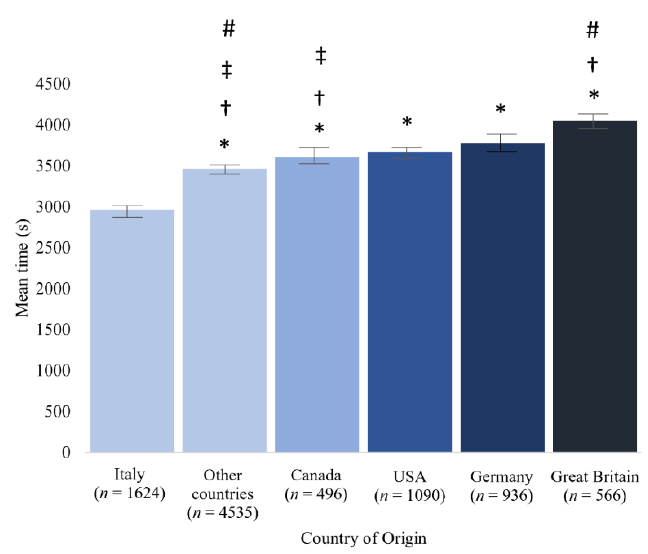
Figure 1. Mean times, confidence interval (95%) and difference between countries in 3000 m open- water swimming between 1992 and 2019. * different from Italy; † different from Germany; ‡ different from Great Britain; # different from USA. The number of participants from each country in each year varied between 1 and 1023. The three countries that most participated in 3000 m open-water swimming WC over the years where Italy had 1646 participations, the USA had 1128 participations and Germany had 959 participations (Table 2). Table 2. Number of athletes from each country who participated in the WC each year (data are from the ten countries that most participated).